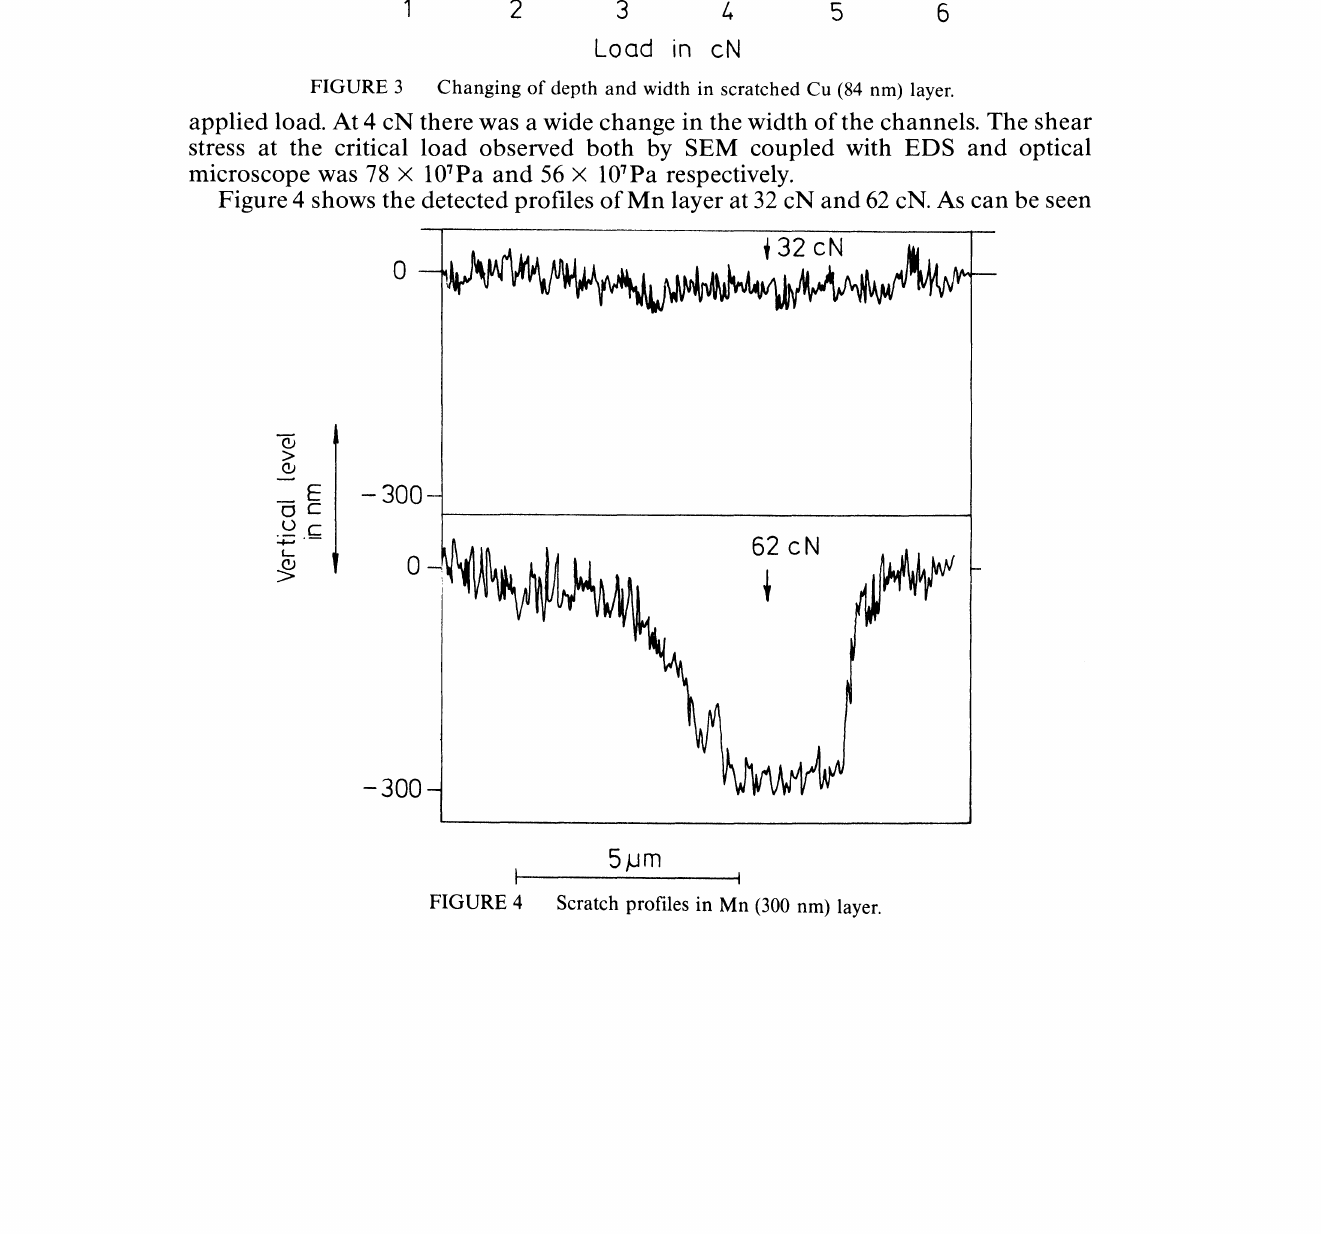
Changing of depth and width in scratched Cu (84 nm) layer.